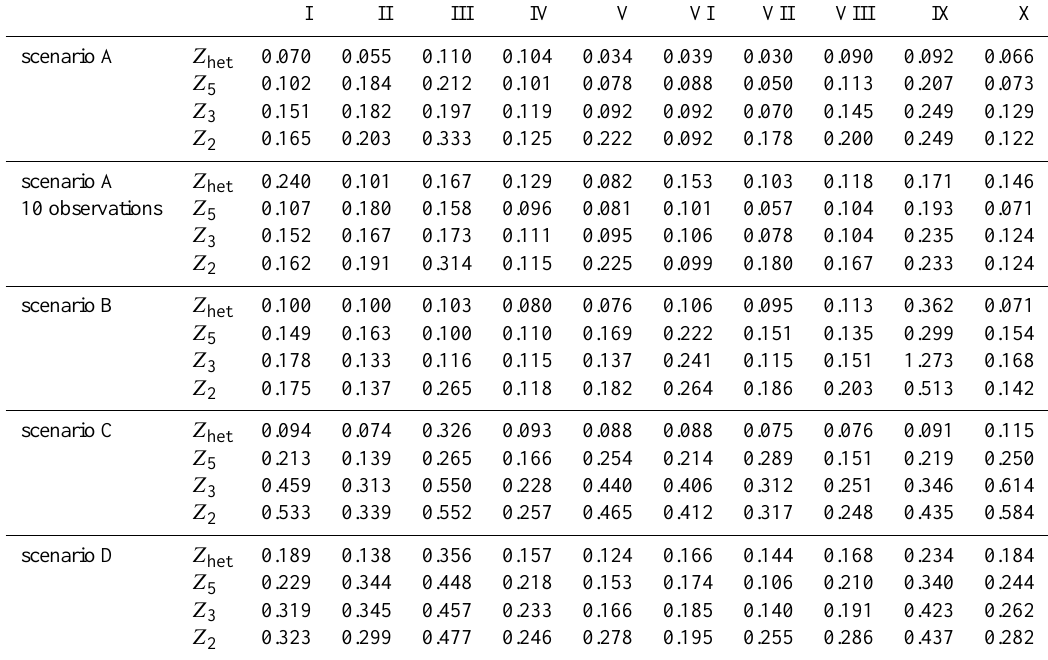
Table 5. Root mean square error of mean hydraulic heads (for the whole model domain) in [m] calculated for the second half of the simulation period (day 300 to day 609). Results are shown for all scenarios and